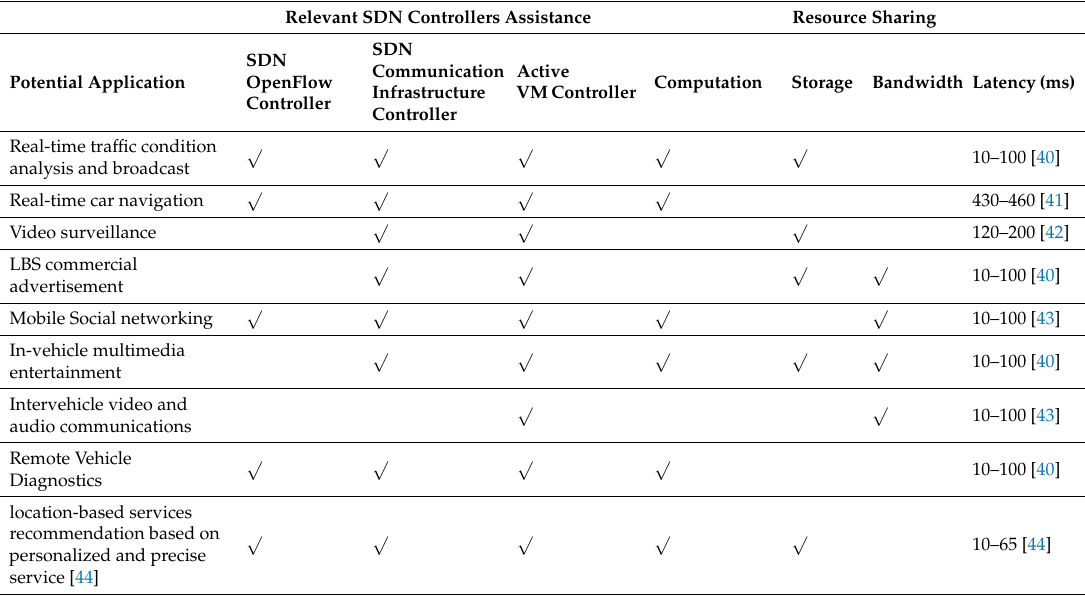
Table 1. Applications based vehicular network over